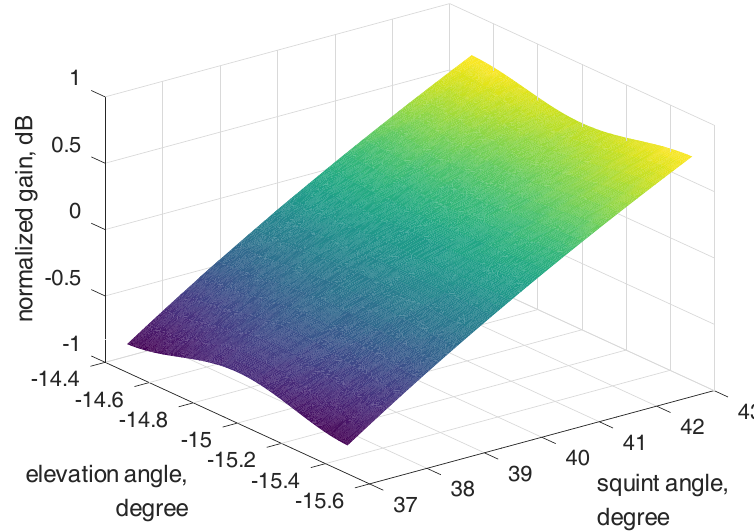
Figure 5. Two-dimensional effect of antenna pattern in the